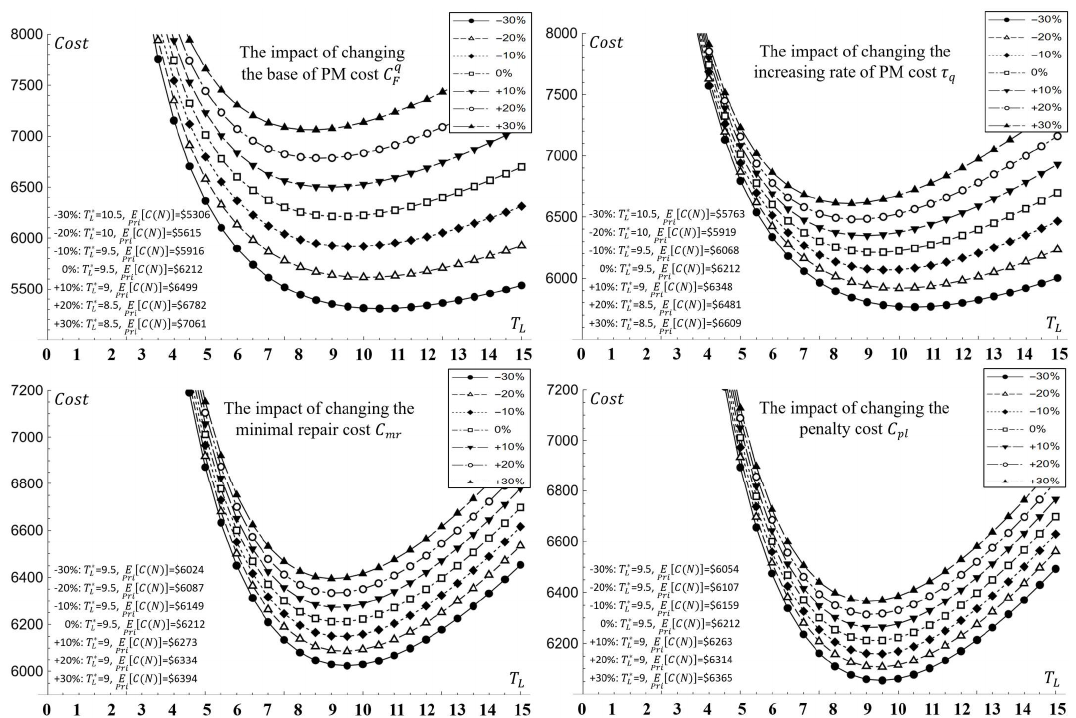
Figure 9. The Impacts of 𝐶 (cid:3007)(cid:3044) , 𝜏 (cid:3044) , 𝐶 (cid:3040)(cid:3045) , and 𝐶 (cid:3043)(cid:3039) on the overall cost per unit and year.